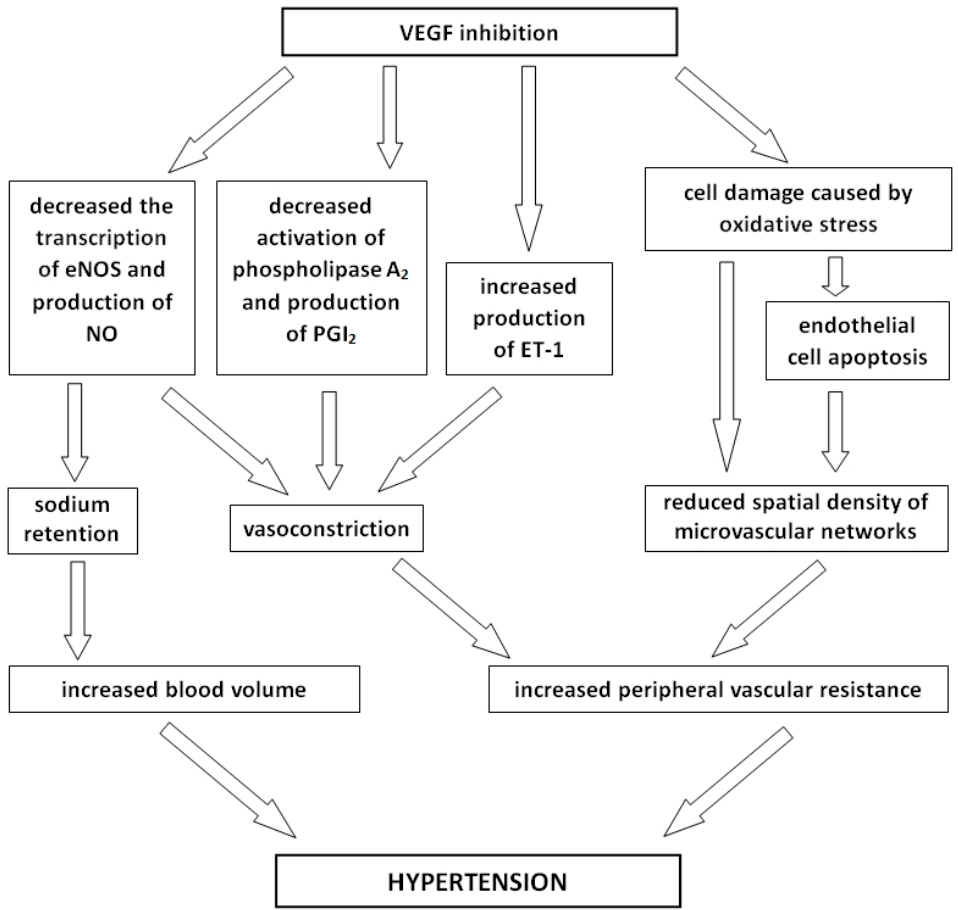
Figure 2. The pathogenesis of hypertension in patients receiving the vascular endothelial growth factor signaling pathway inhibitor (anti-VEGF) therapy. VEGF inhibition leads to decreased transcription of endothelial nitric oxide synthase (eNOS), decreased activation of phospholipase A 2 , and increased production of the endothelin-1 (ET-1). Decreased production of nitric oxide (NO), increased production of prostacyclin (PGI 2 ), and the endothelin-1 (ET-1) resulting in vasoconstriction. The inhibition of VEGF leads to endothelial cell damage and, thereafter, to a reduction in microvascular density. The vasoconstriction and rarefaction resulting from an increase in vascular resistance. Anti-VEGF treatment also results in increased blood volume via sodium retention caused by the decreased NO production. An increased vascular resistance and an increased blood volume are directly related to hypertension development.